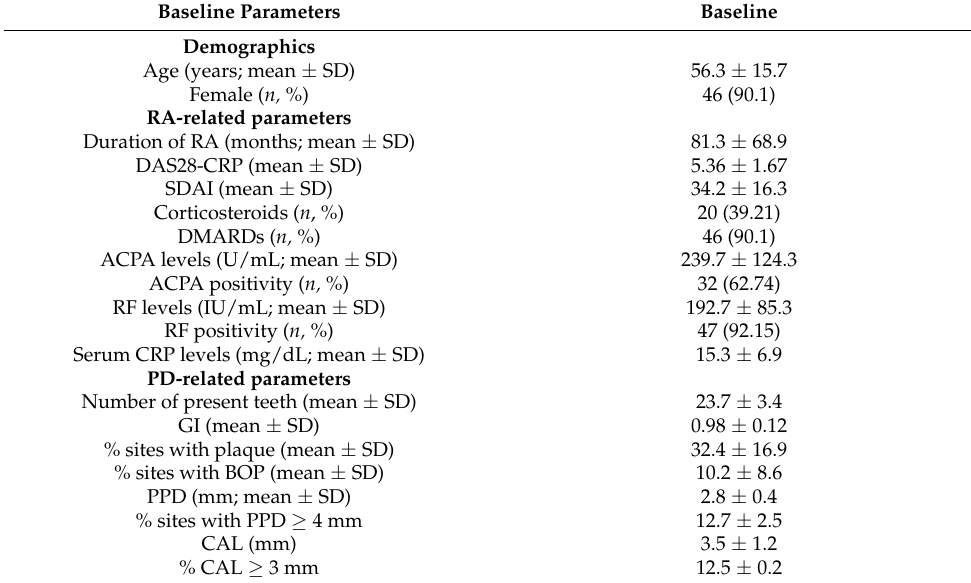
Table 1. Demographic, rheumatologic, and periodontal characteristics at baseline.